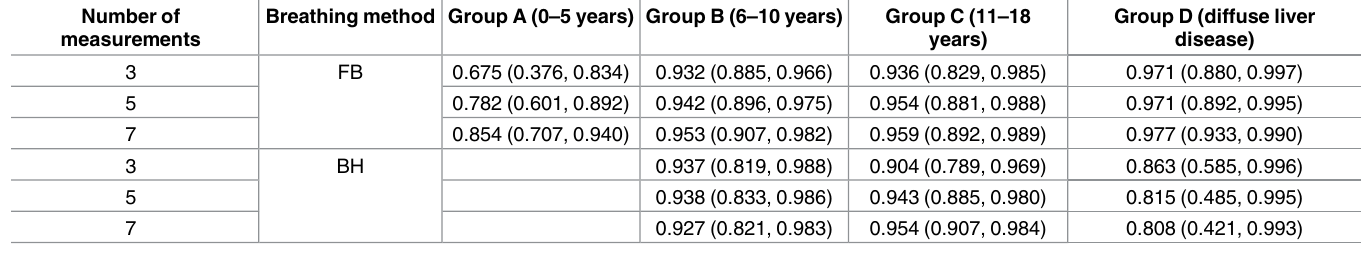
Table 1. Intraclass correlation coefficient (ICC) comparison in four